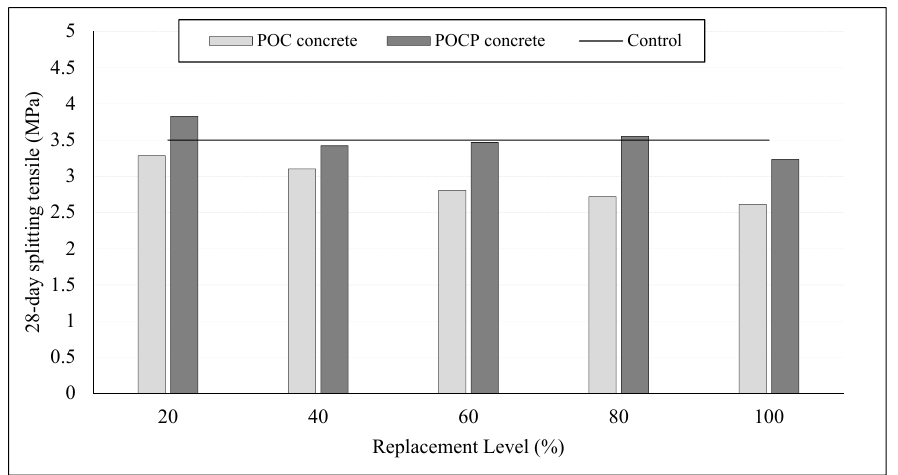
Figure 15. 28-day splitting tensile of POC and POCP concretes. Coatings 2017 , 7 , 175